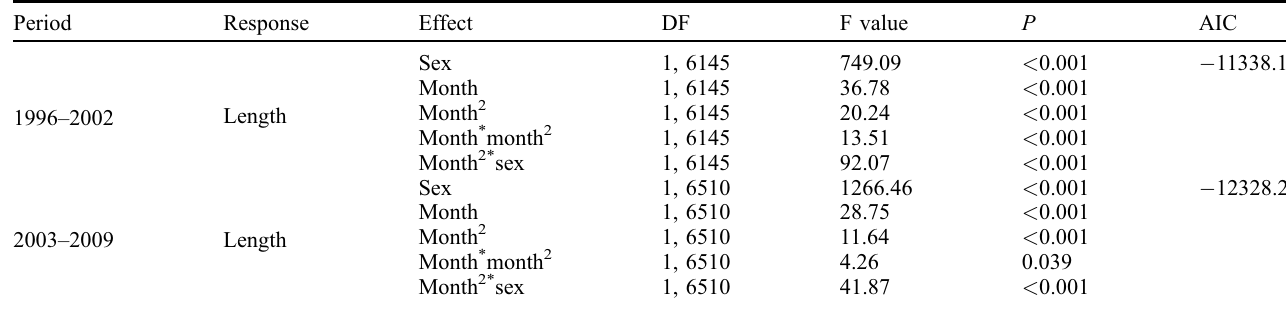
Table A.3. Growth models for 3-6-year-old white fi sh in the GoB separately in two year-class periods. Period